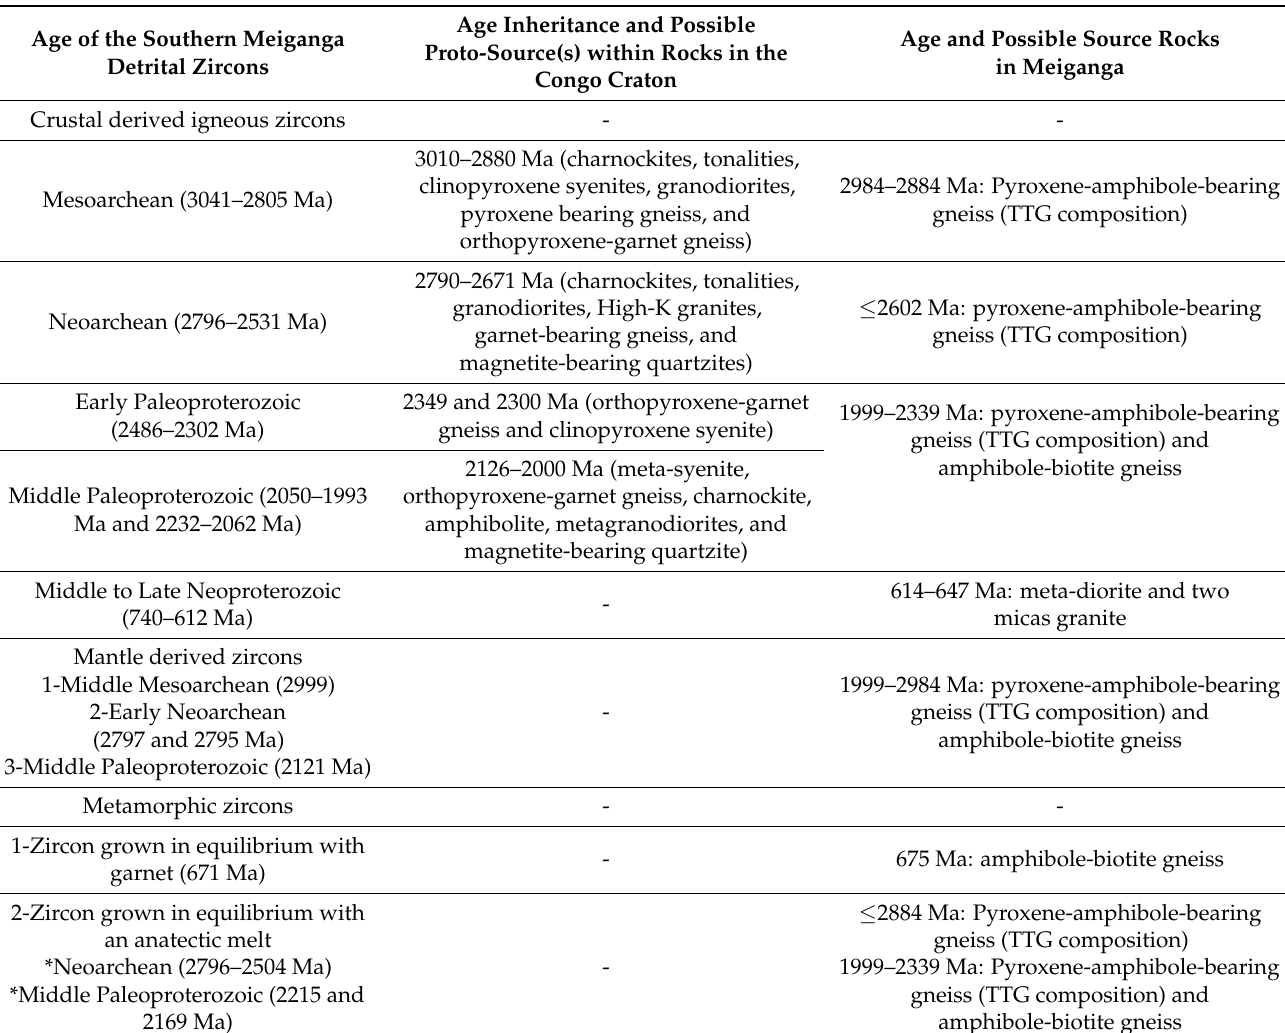
Table 5. Age correlations between the southern Meiganga detrital zircons and other lithounits in the Congo Craton and in